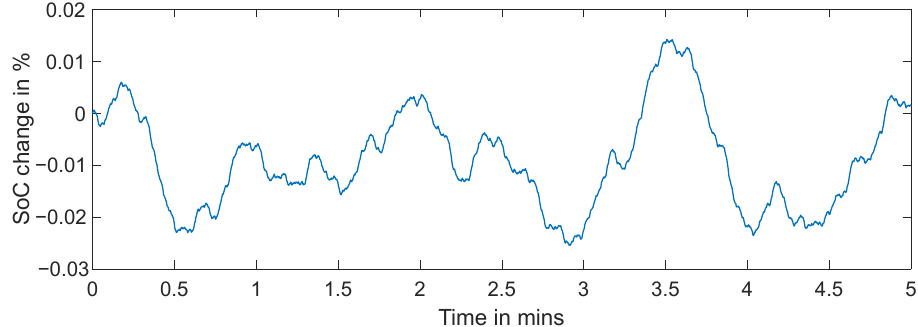
Figure 11. Time profile of the battery state-of-charge during multisine signal injection.